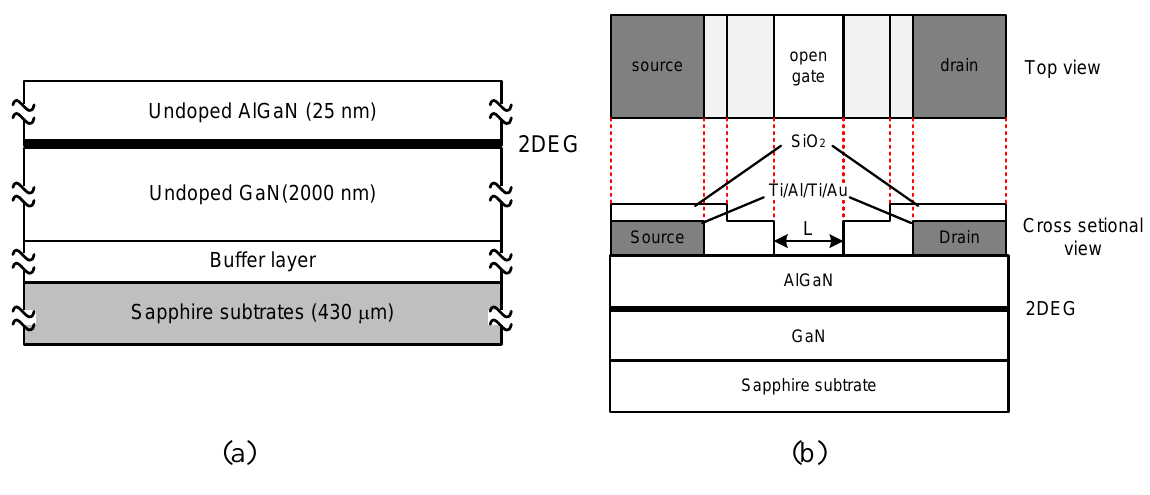
Figure 1. (a) Schematic of material layer structure (cross-sectional view) and (b) schematic of device structure (top and cross-sectional